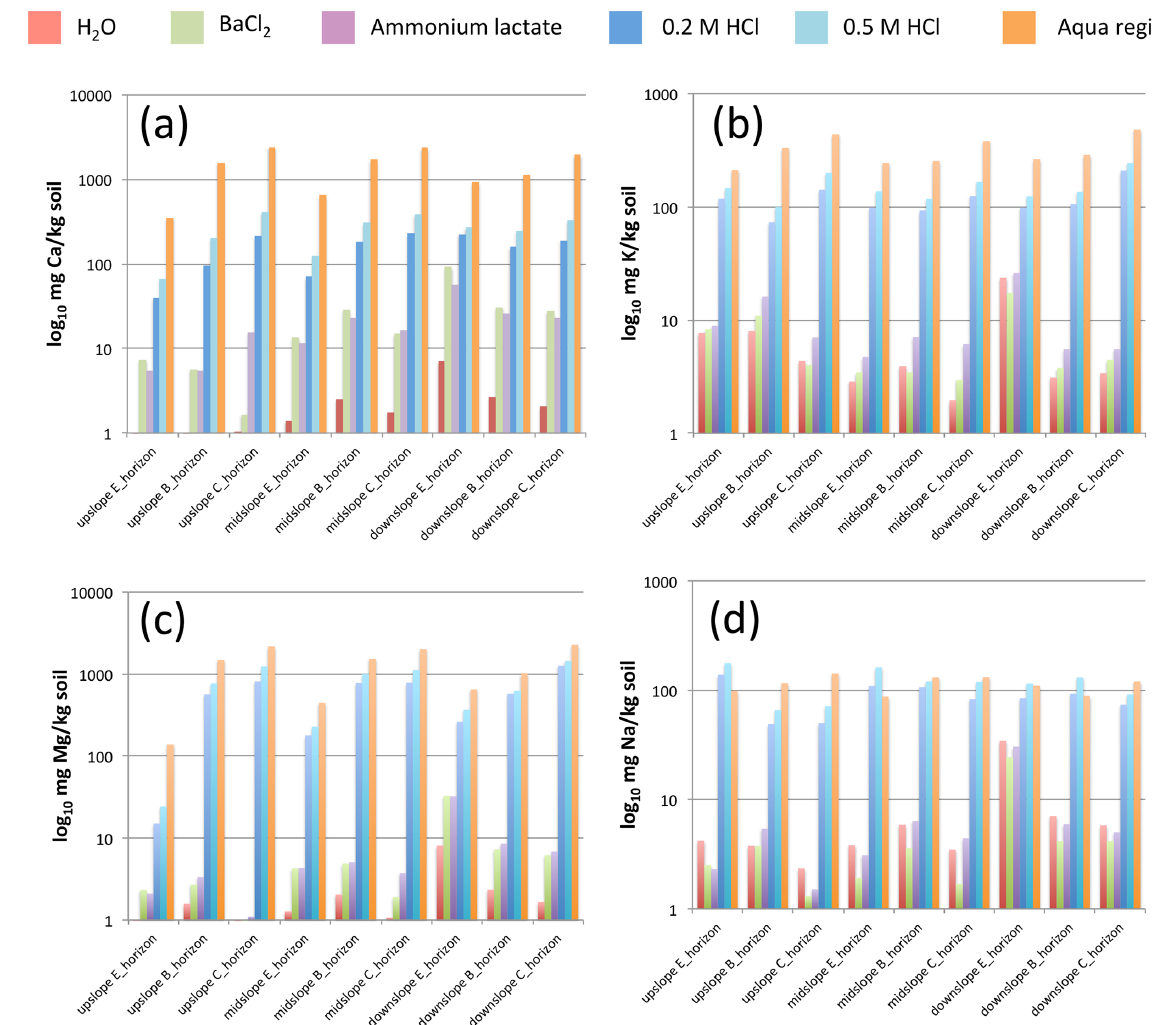
Figure 1. Extractable contents of calcium (a) , potassium (b) , magnesium (c) , and sodium (d) across three soils and three soil horizons obtained form six different chemical extractions. Note the log 10 scale on y axis.